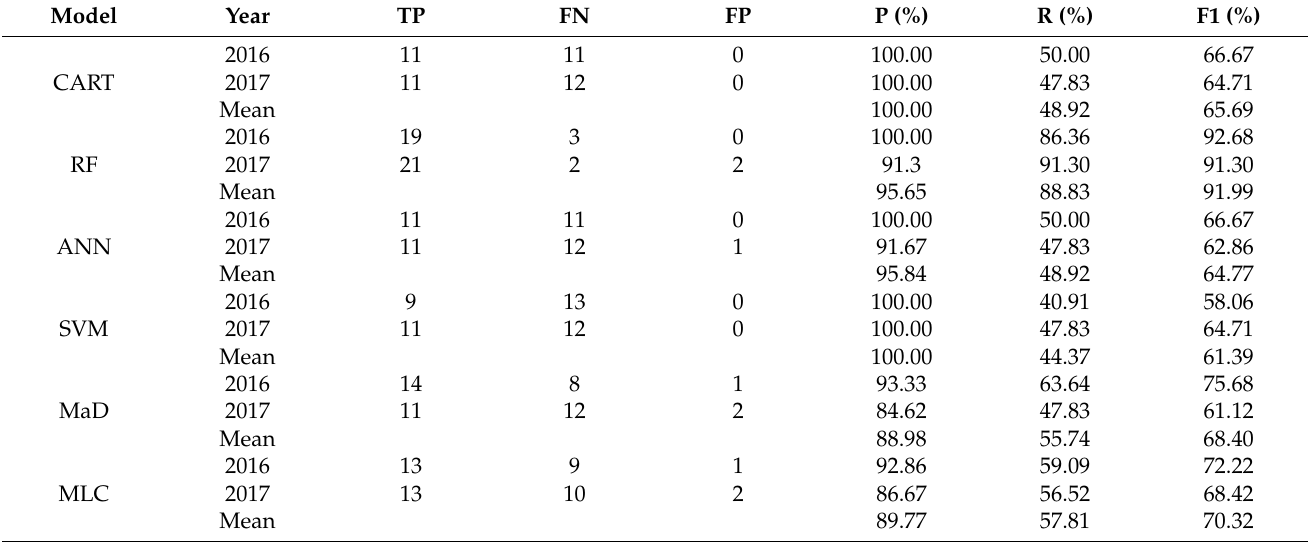
Table 4. Accuracy evaluation in region 4.